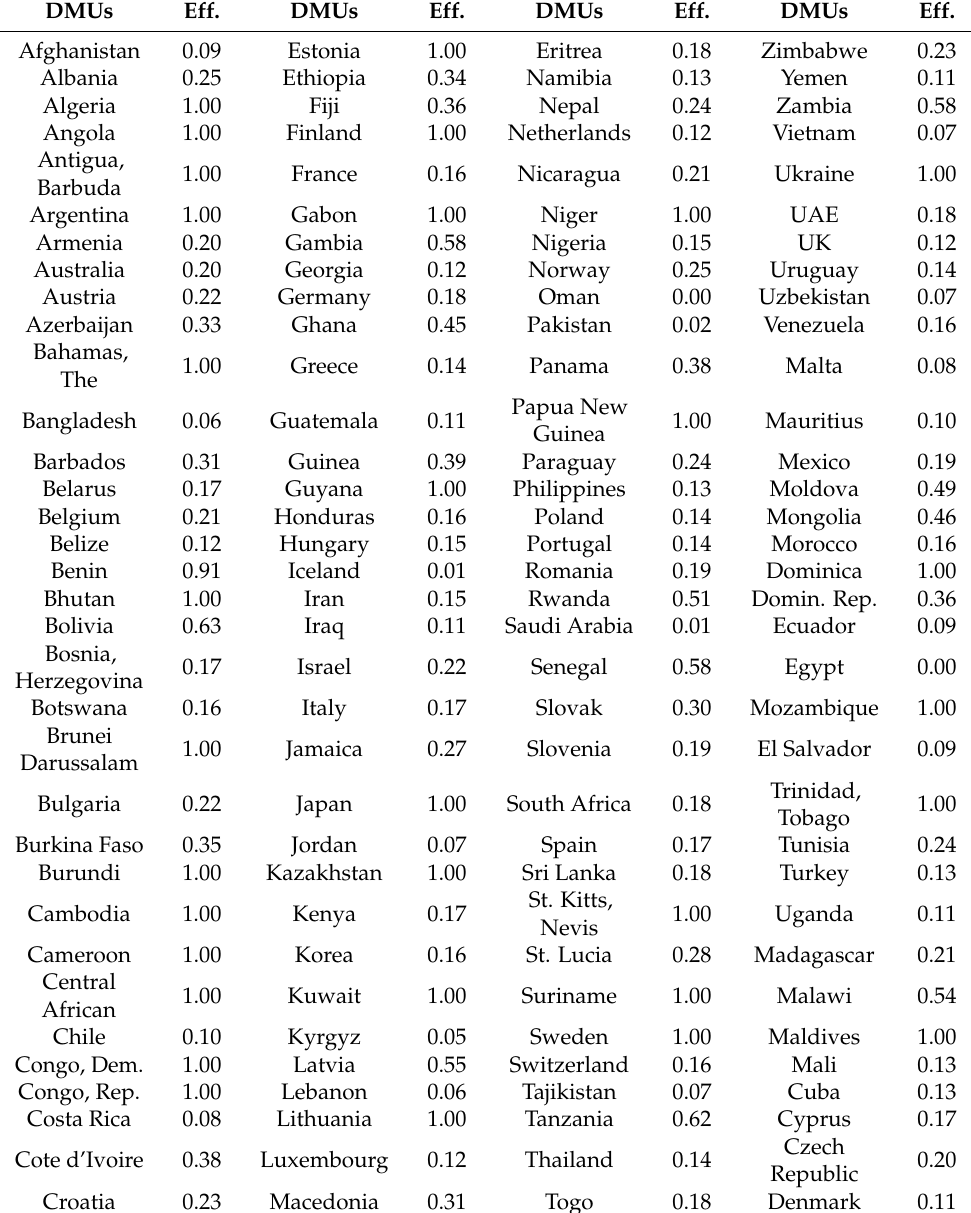
Table 4. The efficiency results of 136 decision making units “DMUs”